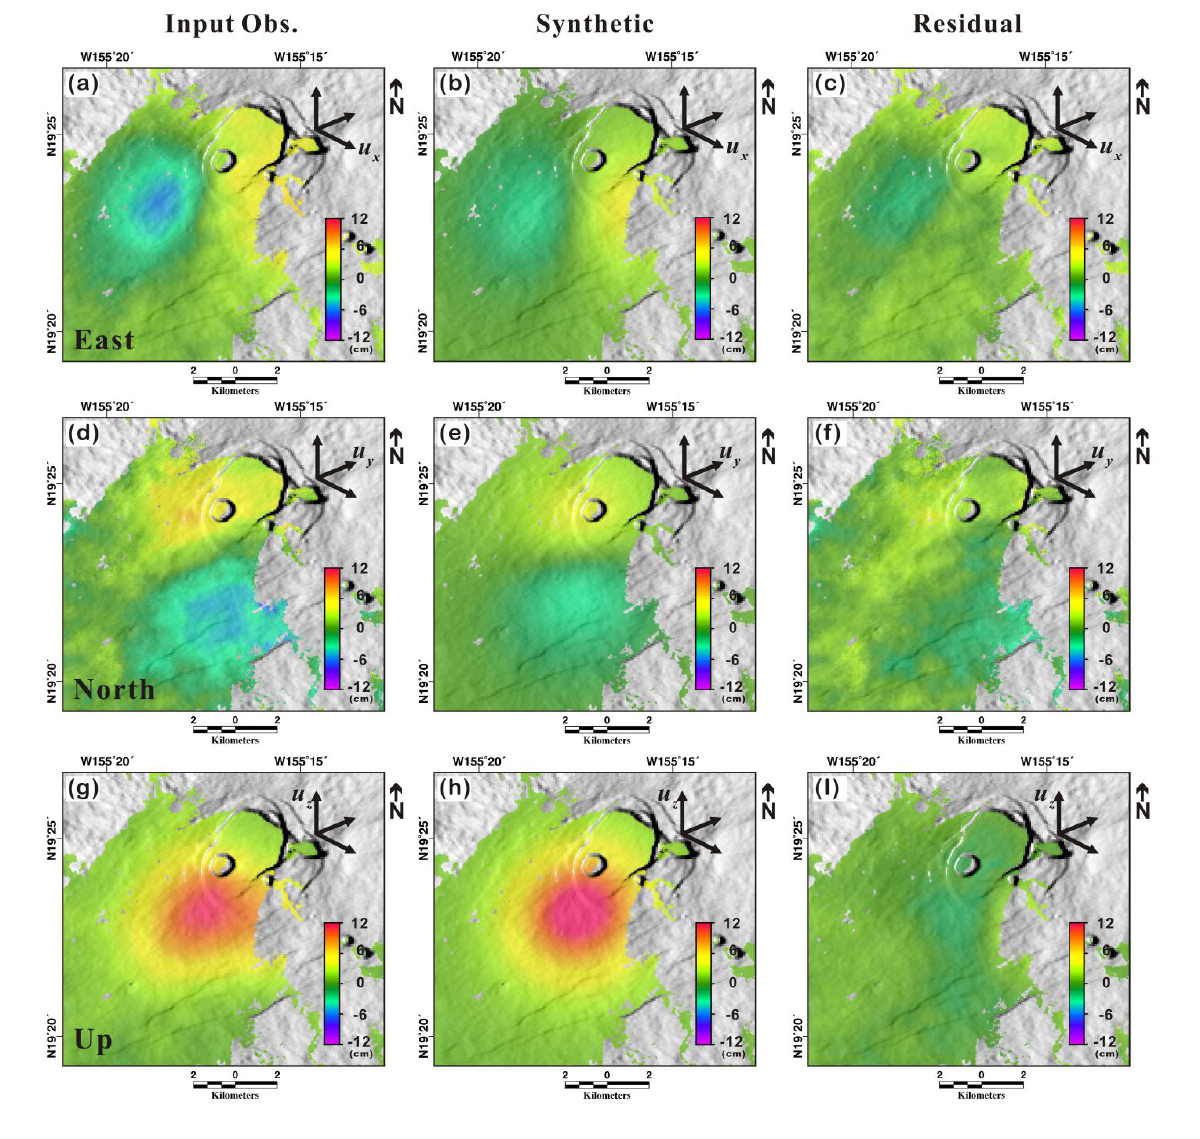
Figure 5. Inversion results of the rectangular dislocation (Okada) model for Kīlauea’s summit area using 3D measurements. The first row shows the ( a ) observed, ( b ) synthetic, and ( c ) residual deformation of the east component. The second row shows the ( d ) observed ( e ) synthetic, and ( f ) residual deformation of the north component. The third row shows the ( g ) observed, ( h ) synthetic, and ( i ) residual deformation of the up component. Table 2. The best-fit model parameters of Kīlauea’s magma source using the Okada dislocation model.